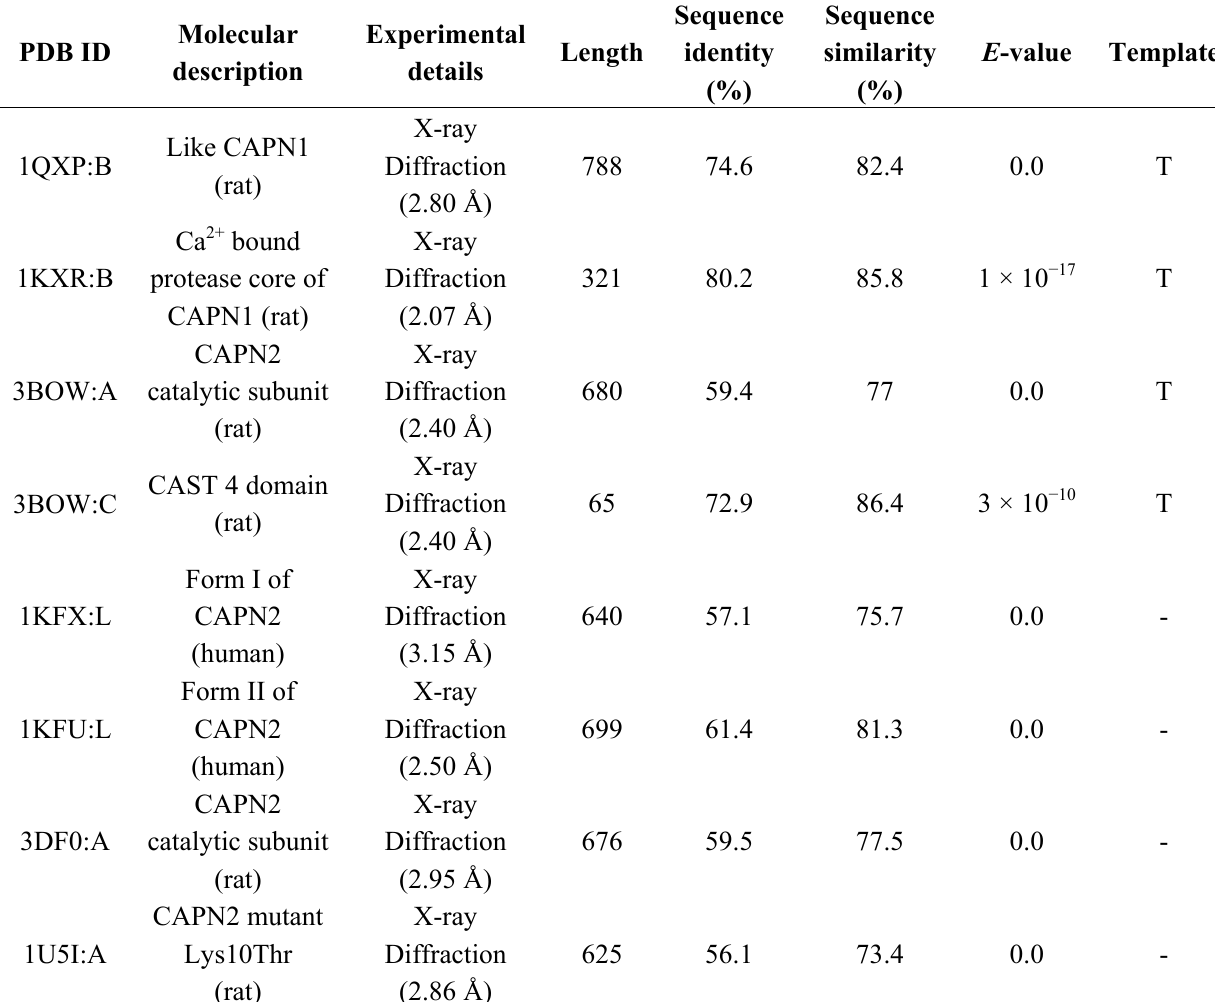
Table 4. Identifying reference proteins for homology modeling the bovine CAPN1. PDB